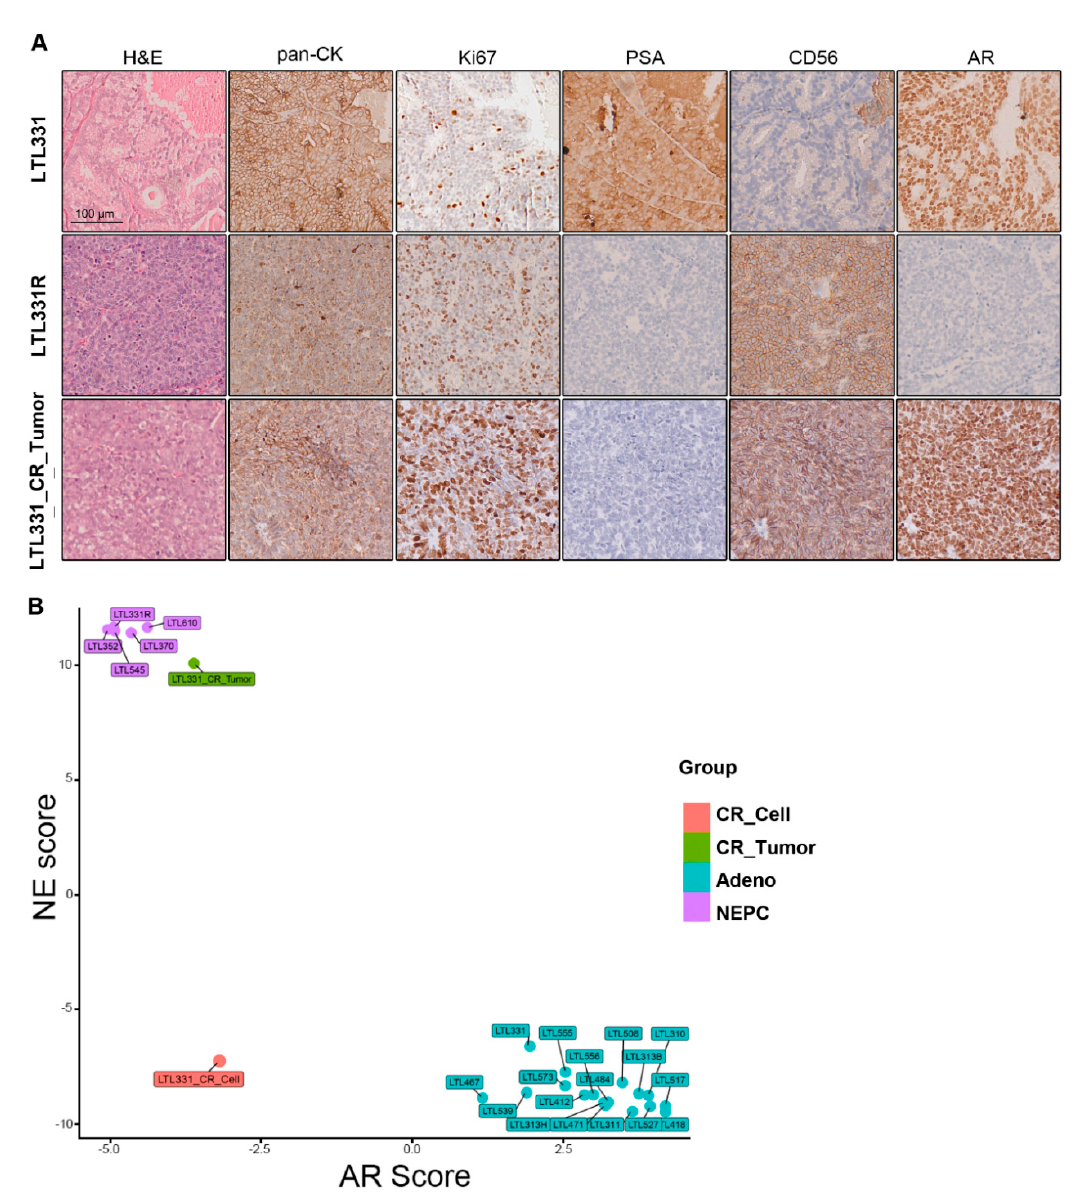
Figure 3. Characterization of LTL331_CR_Tumor as NEPC. ( A ) Representative images showing IHC staining of LTL331, LTL331R, and LTL331_CR_Tumor. H&E, epithelial tumor marker pan ‐ CK, proliferation marker Ki67, NE marker CD56, AR, and AR signaling marker PSA were stained as indicated in the images. Scale bar, 100 μ m. ( B ) AR and NE scores of LTL331_CR_Tumor. NE and AR scores were calculated using transcriptomic data from LTL331_CR_Tumor. The scores were also calculated for other independent PDX models and LTL331_CR_Cell. Sample types are differentially colored based on their histopathological classifications.